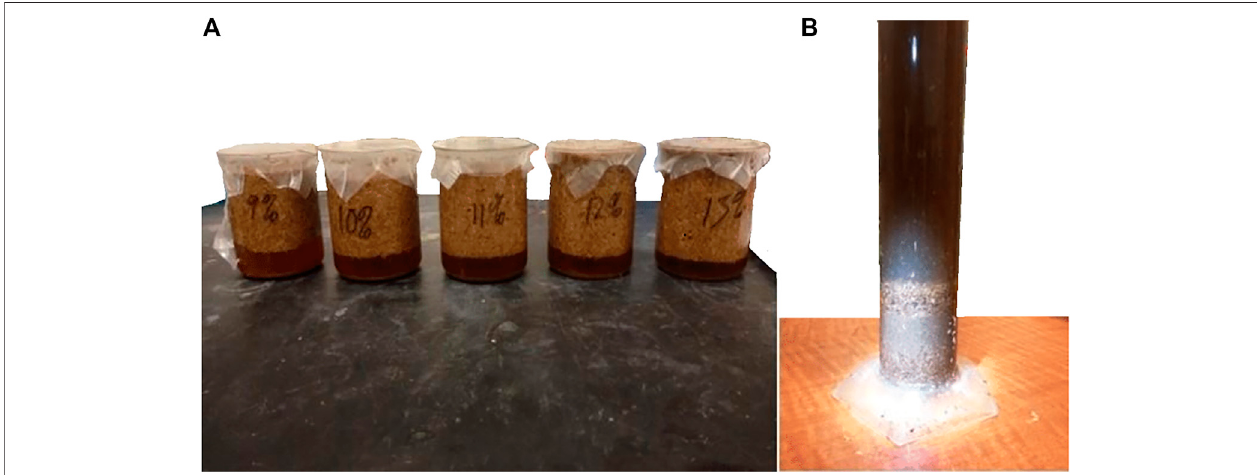
FIGURE 2 | Dilute acid pretreatment switchgrass (A) and energy sorghum (B) illustrating the fl oater and sinker characteristic, respectively. Two seemingly similar herbaceous materials pre-processed and thermochemically pre-treated behave quite differently when suspended in liquid. Thus, the equipment design and process for the transport of materials needs is unique for speci fi c feedstock properties throughout the